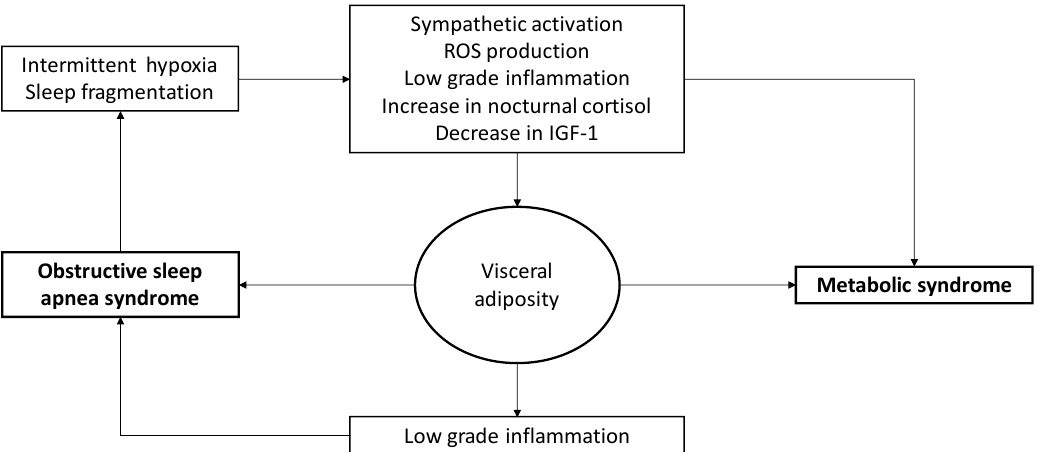
Figure 2. Bidirectional relationship between obstructive sleep apnea syndrome and metabolic syndrome. ROS, reactive oxygen species; IGF-1, insulin-like growth factor 1.